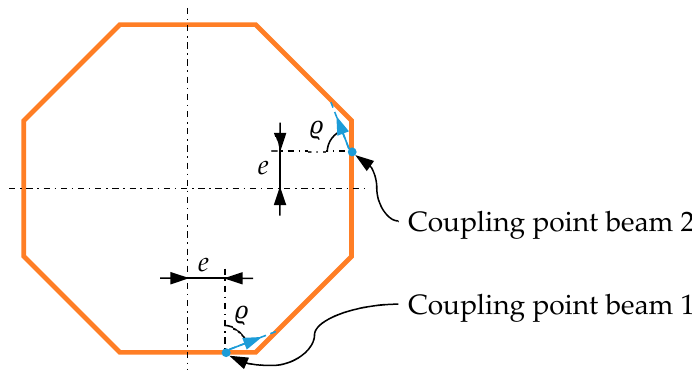
Figure 13. Coupling points of two laser beams at the first face of the prism rod.